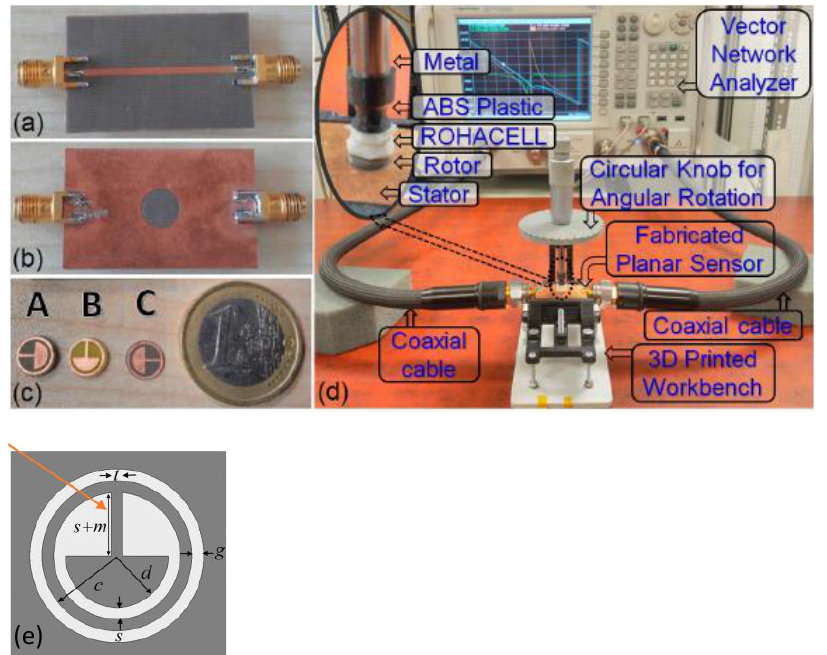
Figure 16. Photographs of the phase-variation sensor system based on a microstrip line loaded with a rotatable CSRR. ( a ) Bottom and ( b ) top views of the stator, fabricated on the 0.5-mm-thick RT5880 substrate with dielectric constant ε r = 2.2 , and dissipation factor tan δ = 0.009; ( c ) rotor A (1.5-mm-thick RT5880 laminate, ε r = 2.2 , tan δ = 0.009), rotor B (1-mm-thick FR4 laminate, ε r = 4.3, tan δ = 0.025), and rotor C (0.5-mm-thick RT5880 laminate); ( d ) measurement setup for directional angular rotation. The microstrip line length and width are 40 mm and 1.49 mm. The dimensions of the MCSRR, in regard to the ( e ) zoom view topology, are: c = 3.5 mm, d = 1.5 mm, s = 0.5 mm, t = 0.5 mm, g = 0.5 mm. Reprinted with permission from [65].